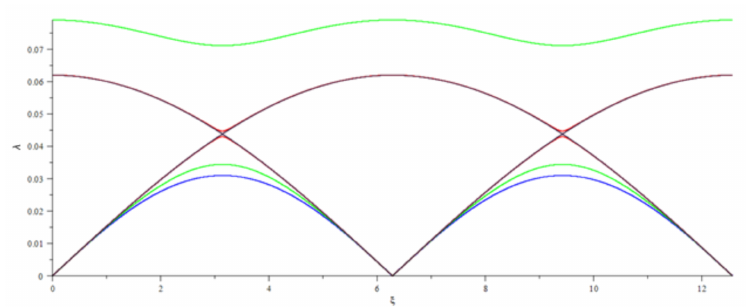
Figure 7. The appearance of a smaller spatial period during the crushing of the components of a monodisperse crystal with a constant concentration of the form 0.25 + 0.25 + 0.25 + 0.25. Here: N3: 0.5 + 0.5 + 0 + 0, color = blue; N4: 0.25 + 0.24 + 0.25 + 0.26, color = red; N5: 0.3 + 0.2 + 0.2 + 0.3, color = green; N6: 0.25 + 0.25 + 0.25 + 0.25, color = violet. Splitting the components in half, each component is divided into 2 equal parts (two